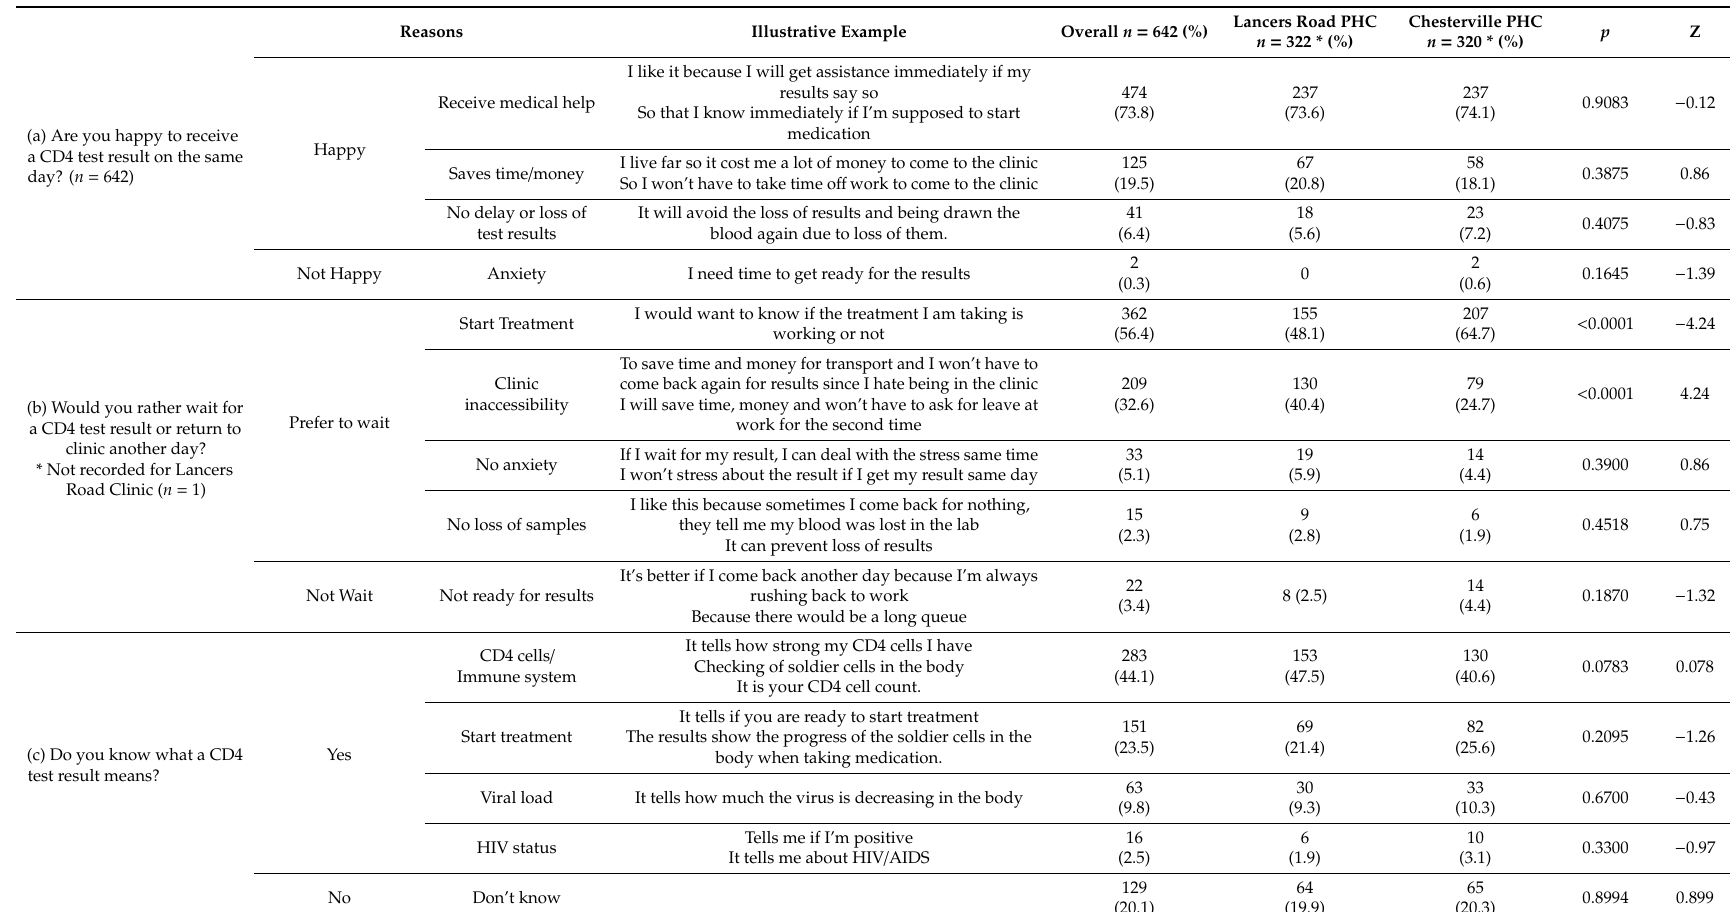
Table 1. Patients’ understanding and perceptions of the impact of a point-of-care (POC) laboratory provision of a CD4 test result at the primary healthcare (PHC) facility on their